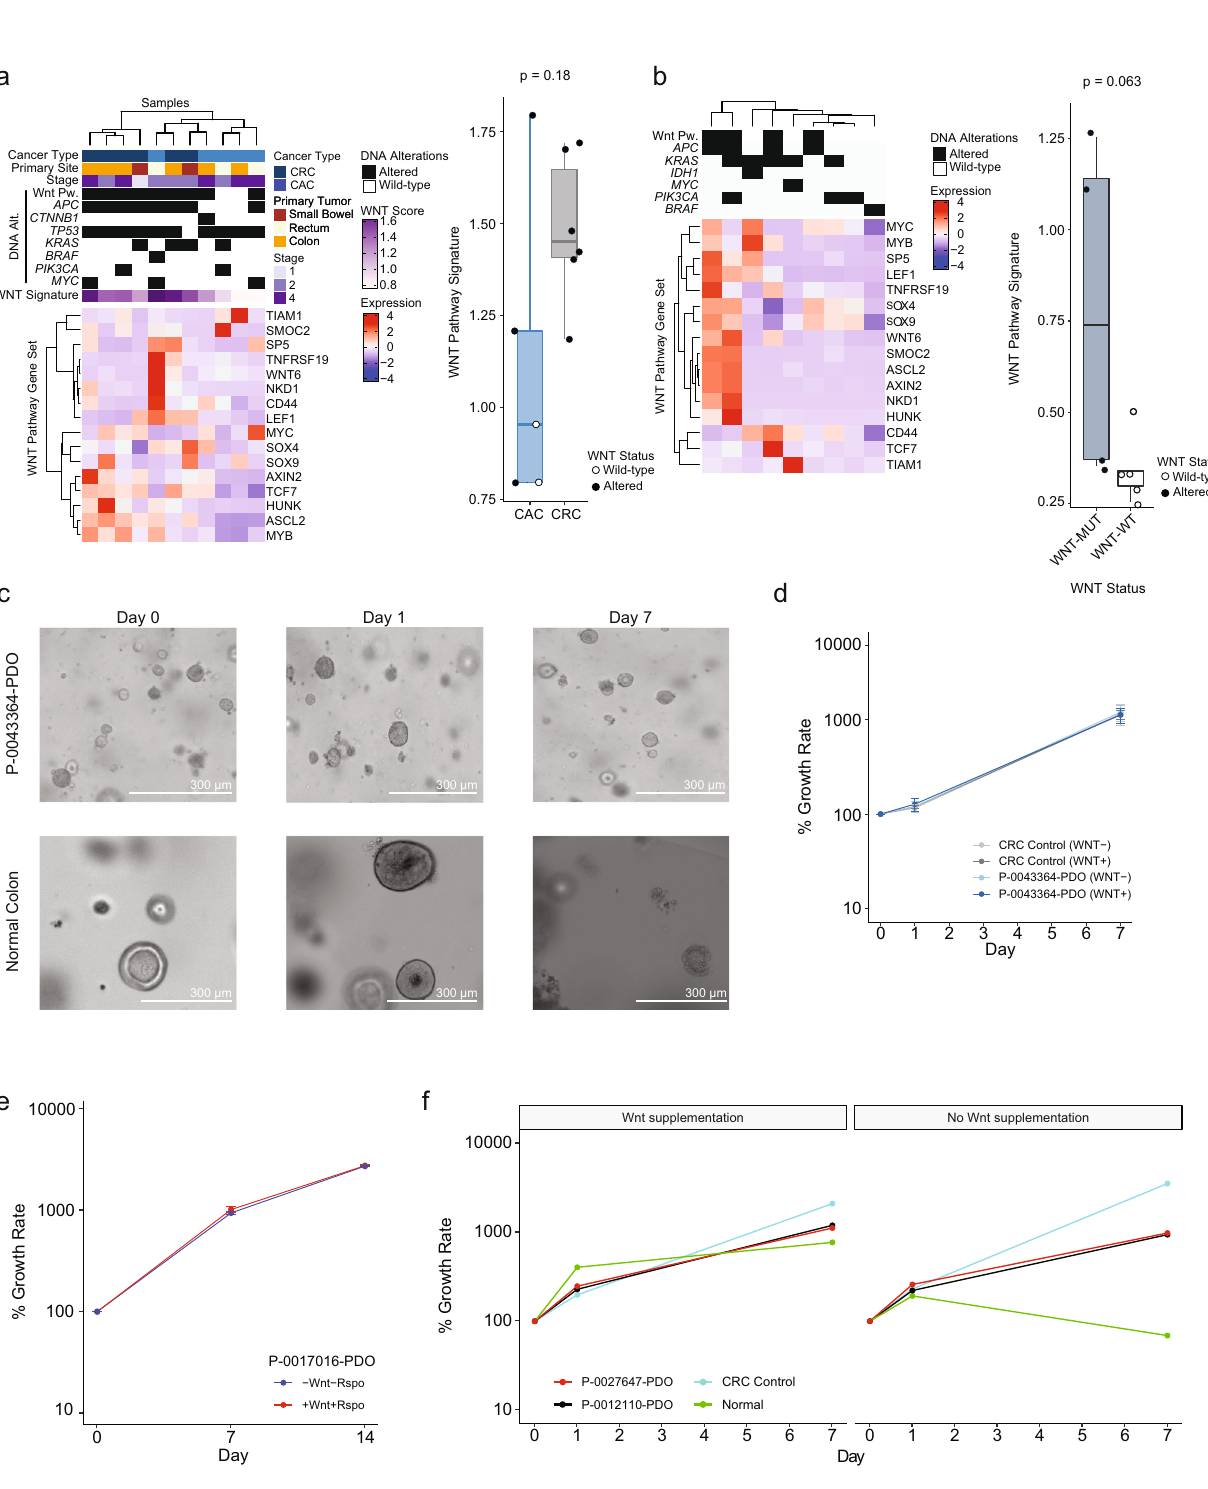
are shown for 1033 clinical IMPACT cases. The CAC ( n =112) and CRC ( n =921) groupswerecomparedusingatwo-sidedMann – WhitneyU-testand the signi fi cant results are asfollows: CAC versus CRC broad CNA score, P =0.000016. The center line of the boxplots indicates the median, the edges indicate the interquartile range, and the whiskers extend to the highest and lowest values not considered outliers. The asterisk shows when the comparisons were signi fi cant (* indicated signi fi cancehere).SourcedataareprovidedasaSourceData fi le.Abbreviations: Dx diagnosis; Norm normal; mCRC metastatic colorectal